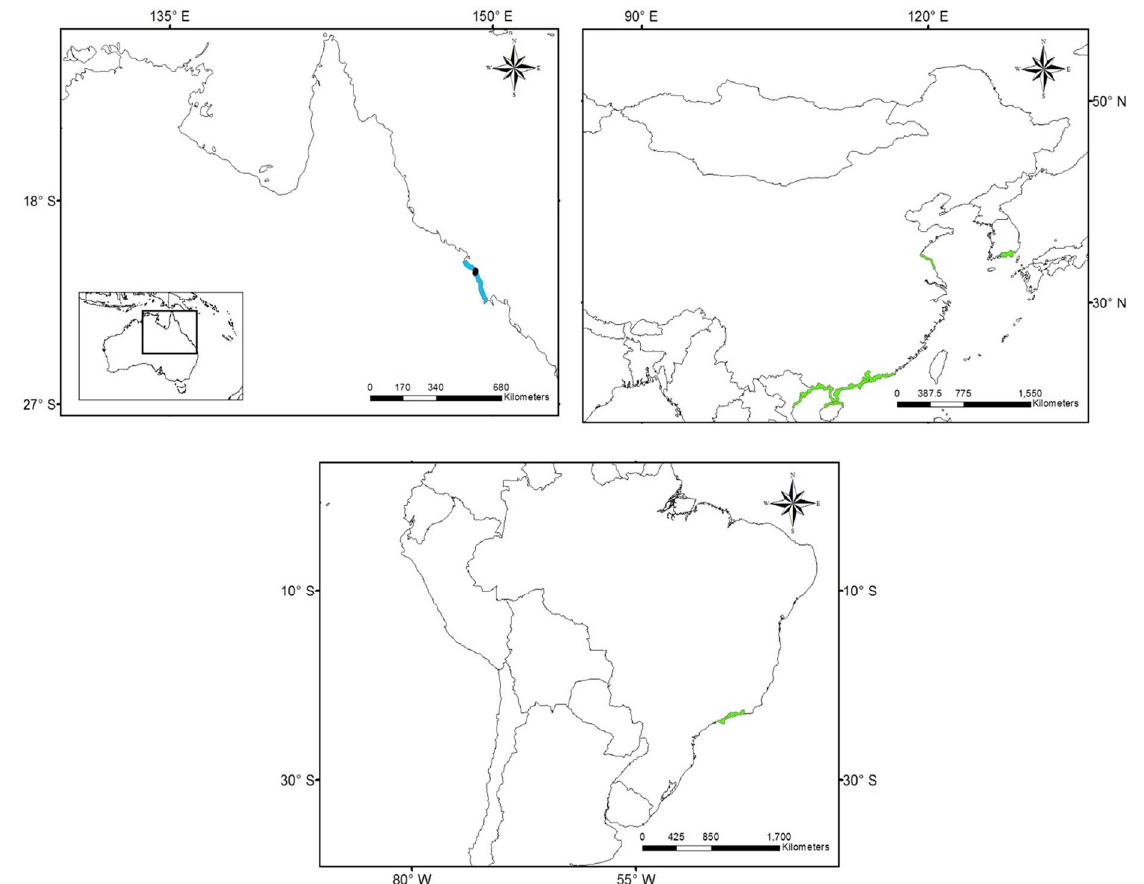
Figure A8. Training (blue) and projection (green) areas for the construction of the models corresponding to Dry-winter humid subtropical climate (Cwa). Black dots represent occurrence records.